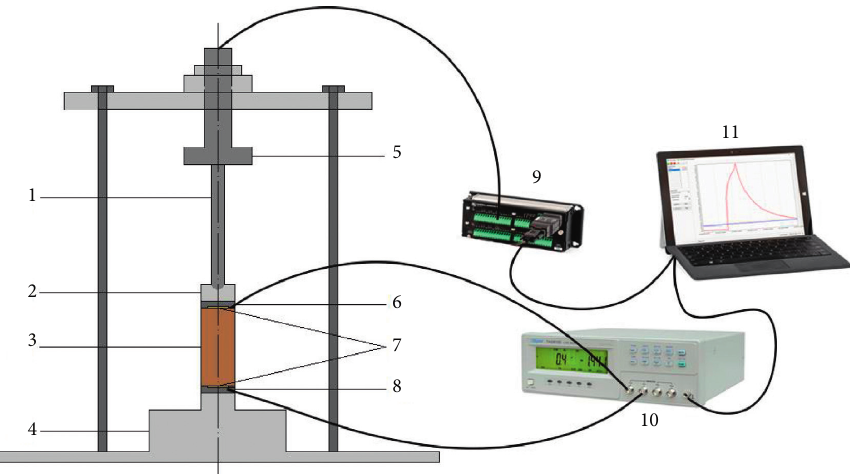
Figure 2: Schematic diagram of the developed triaxial apparatus. Notes:1: vertical loading unit; 2: loading piston; 3: soil sample; 4: pedestal; 5: pressure sensor; 6: upper porous stone; 7: electrodes; 8: lower porous stone; 9: dara logger; 10: LCR digital electric bridge; 11: computer.